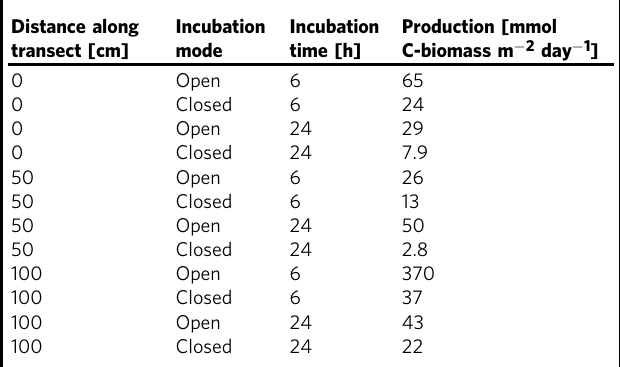
Table 1 Areal chemosynthetic production rates inferred from in situ incubations. See text for